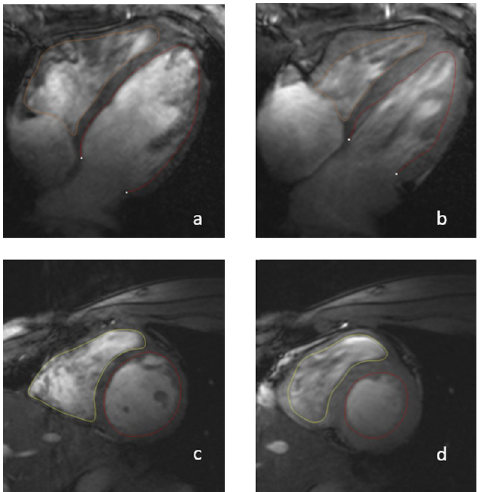
Fig 6. Representative segmentation on four chamber view in a) diastole and b) systole and short axis in c) diastole and d) systole. The segmentation lines were drawn with Medis Suite MR 3.2.